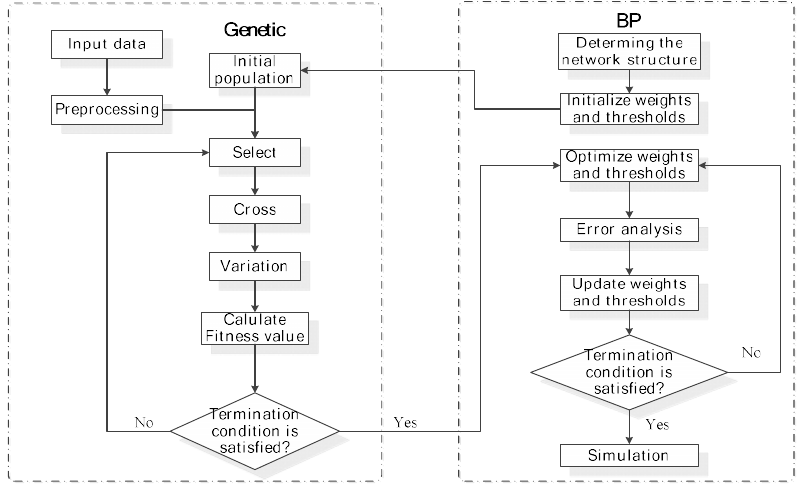
Figure5. General structures of the Genetic_BP model. Figure 5. General structures of the Genetic_BP